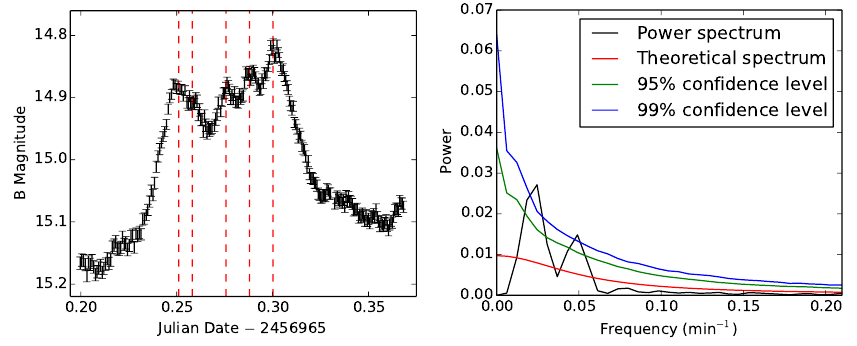
Figure 2. (Left panel): Light curve in the B band on JD 2456965, five sub-flares are marked by vertical dashed lines; (Right panel): Lomb-Scargle periodogram of light curve on JD 2456965.